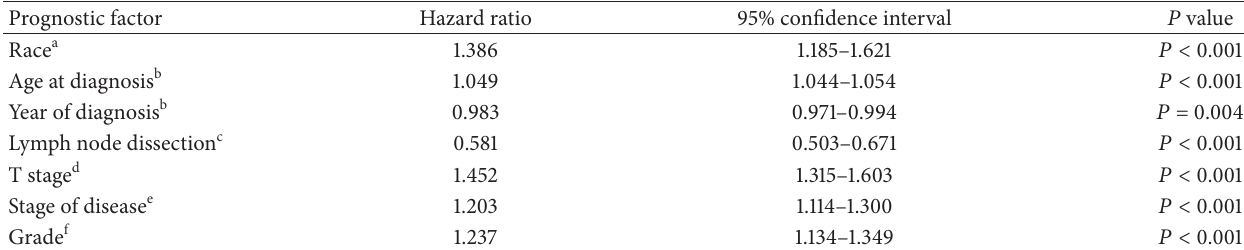
Table 5: Cox regression multivariate